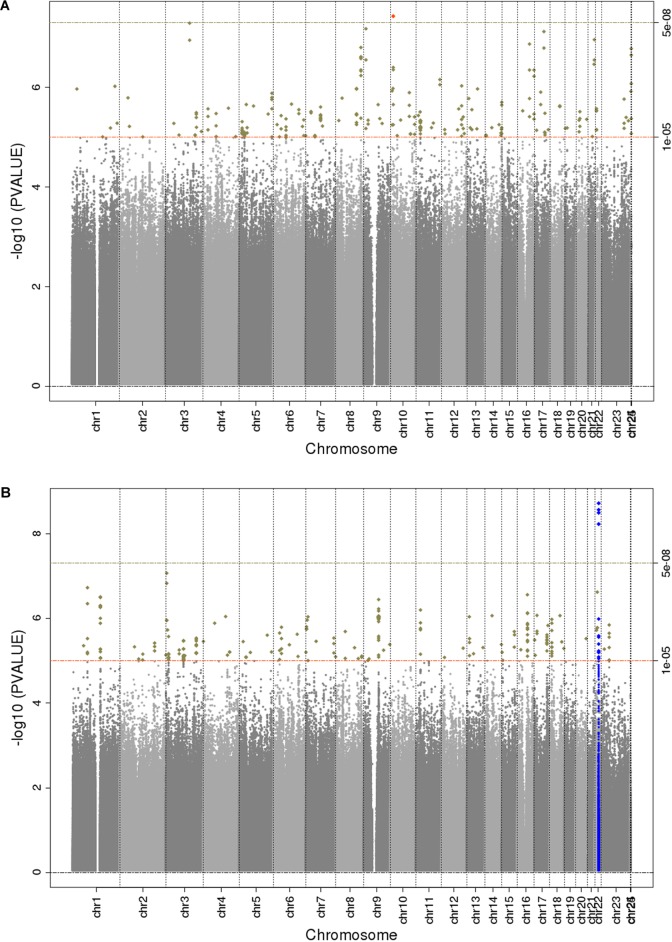
Manhattan plots for trans-ethnic GWAS of CKD (A) and ESKD (B). Significant novel (red) and known (blue) loci are highlighted.